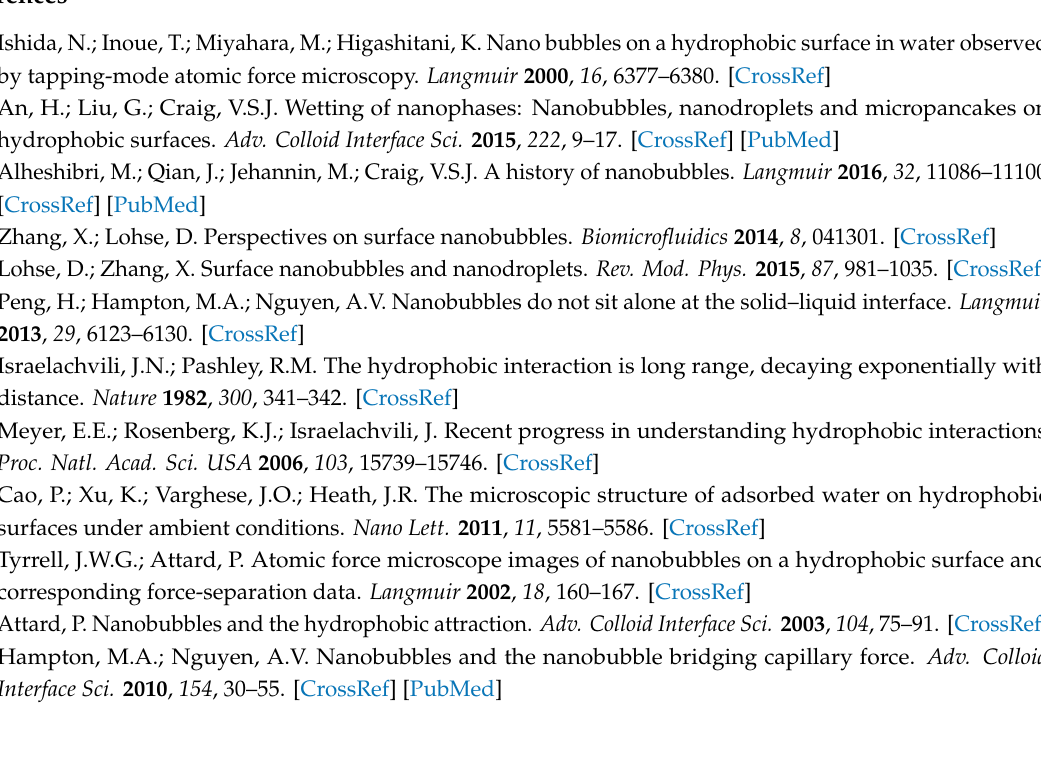
Figures S1 and S2: additional AFM images of HOPG and PbS surfaces. Figure S3: photographs of the sessile water droplets cooled to 0.2 ◦ C and placed on mineral plates, Figures S4 and S5: schemes of Gorevskoye Pb-Zn sulfide ore flotation in di ff erent regimes, Tables S1–S5: results of the bulk sulfide flotation of Gorevskoye Pb-Zn ore for di ff erent